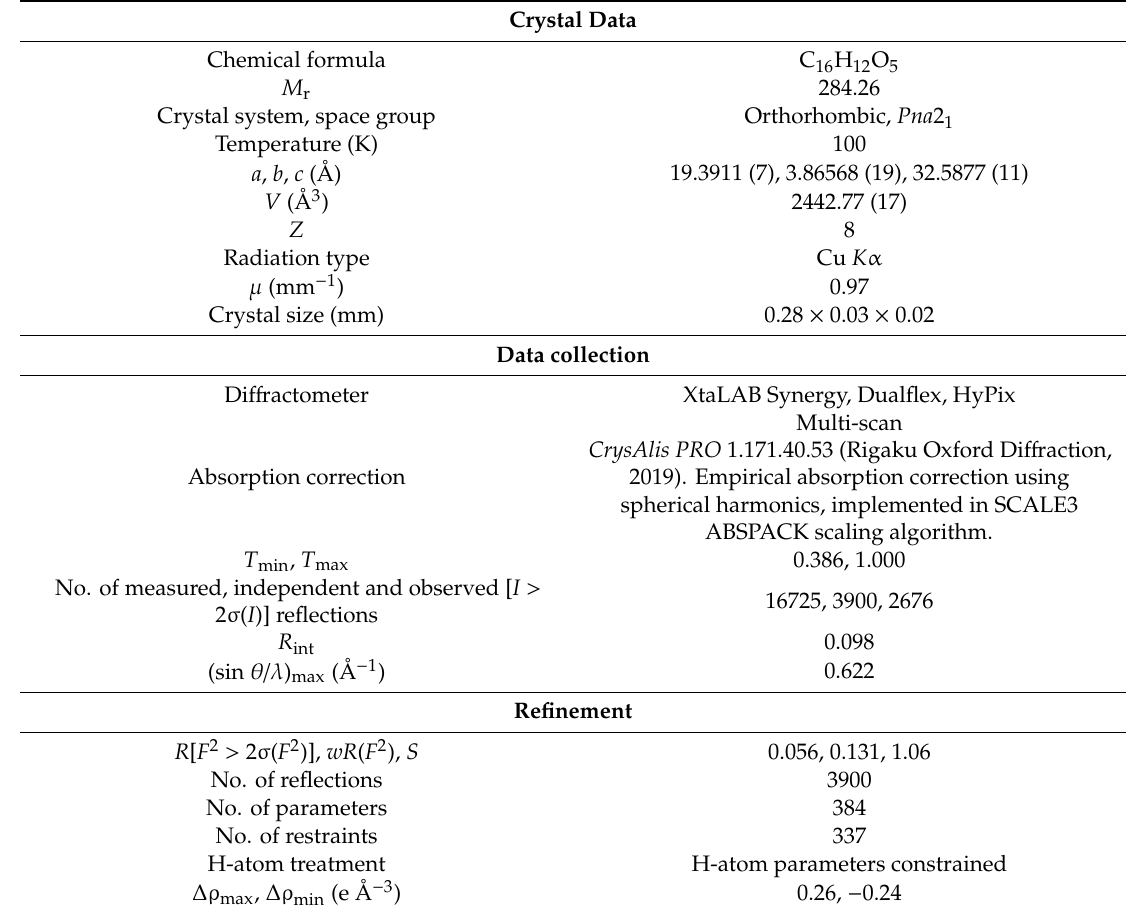
Table 1. Experimental